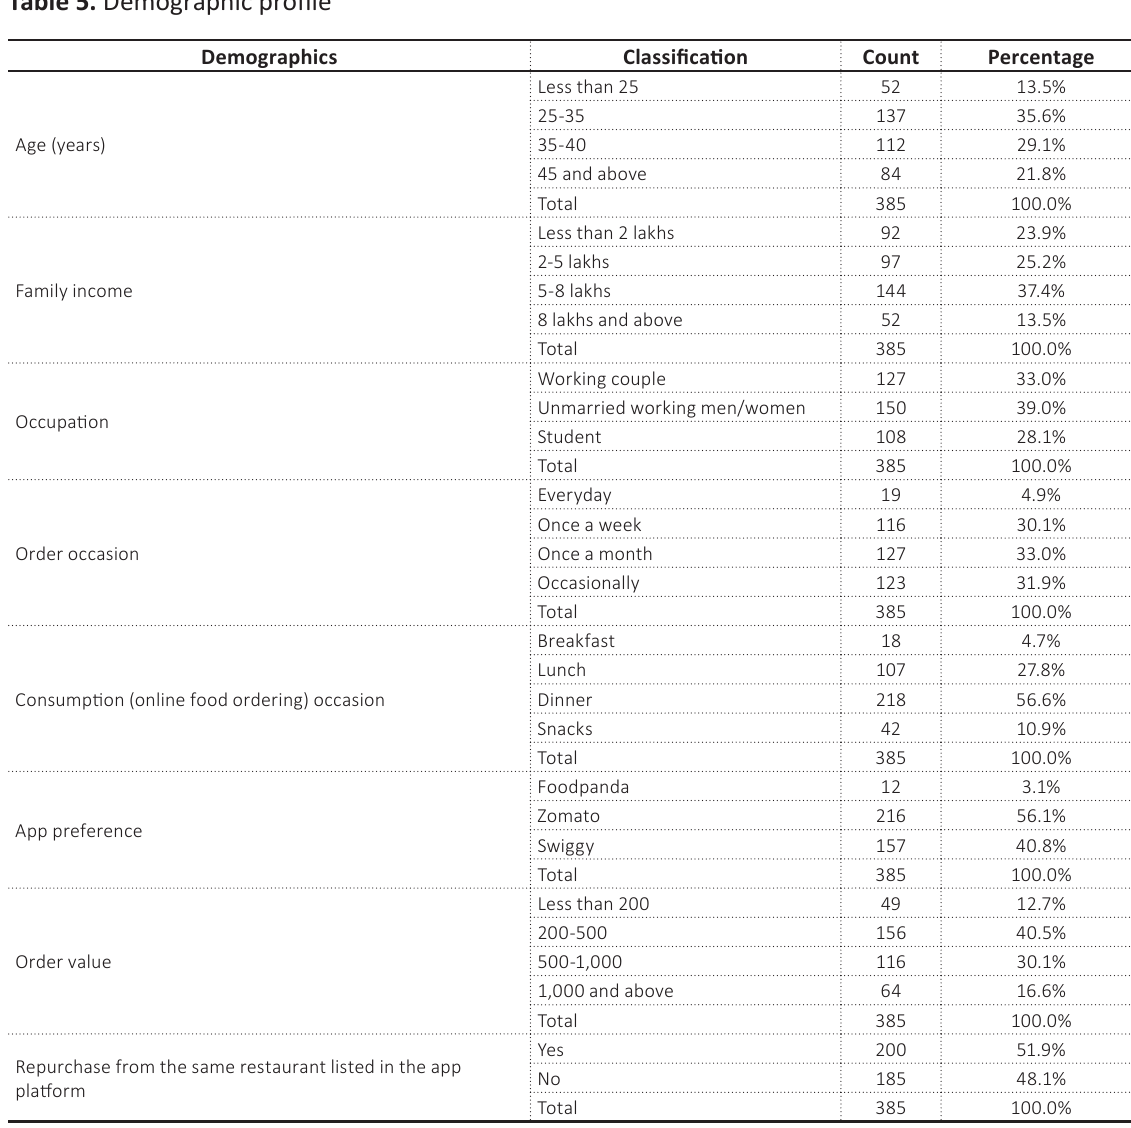
Table 5. Demographic